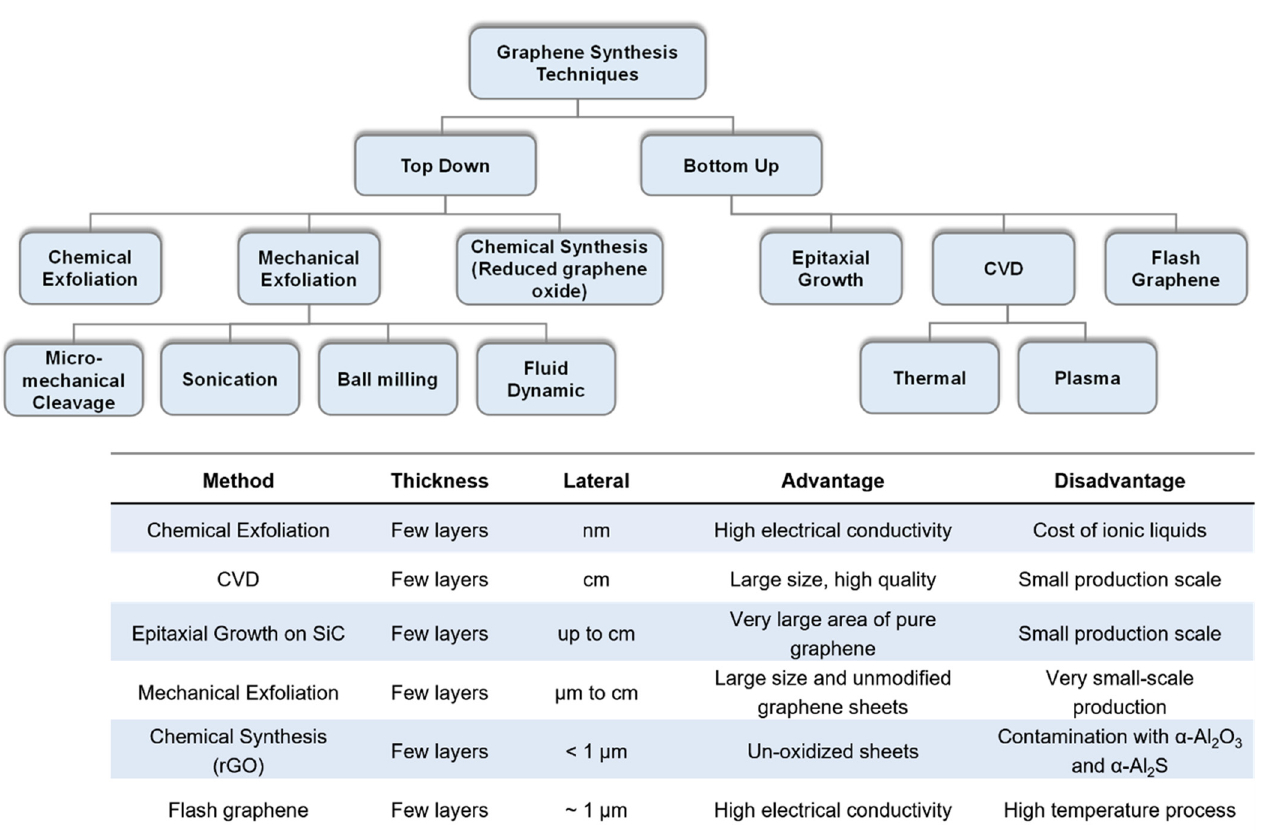
Figure 2. Overview of the most common techniques to obtain graphene categorized based on top-down and bottom-up processes, along with a tabular comparison on the thickness, lateral size, fundamental advantages and disadvantages of each technique. Reprinted with permission from ref. [74] .